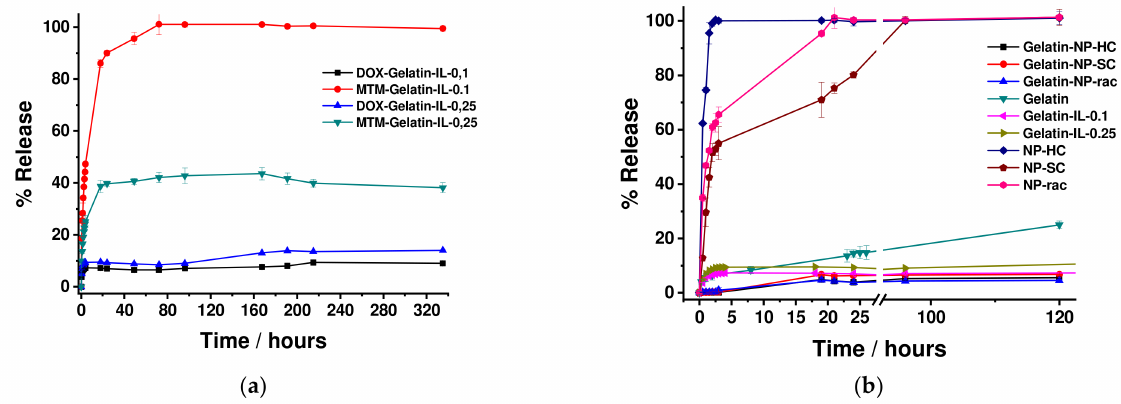
Figure 19. ( a ) DOX and MTM release from the GE/10IL and GE/25IL; ( b ) Comparison of the DOX release from different drug delivery systems, mainly based on gelatin